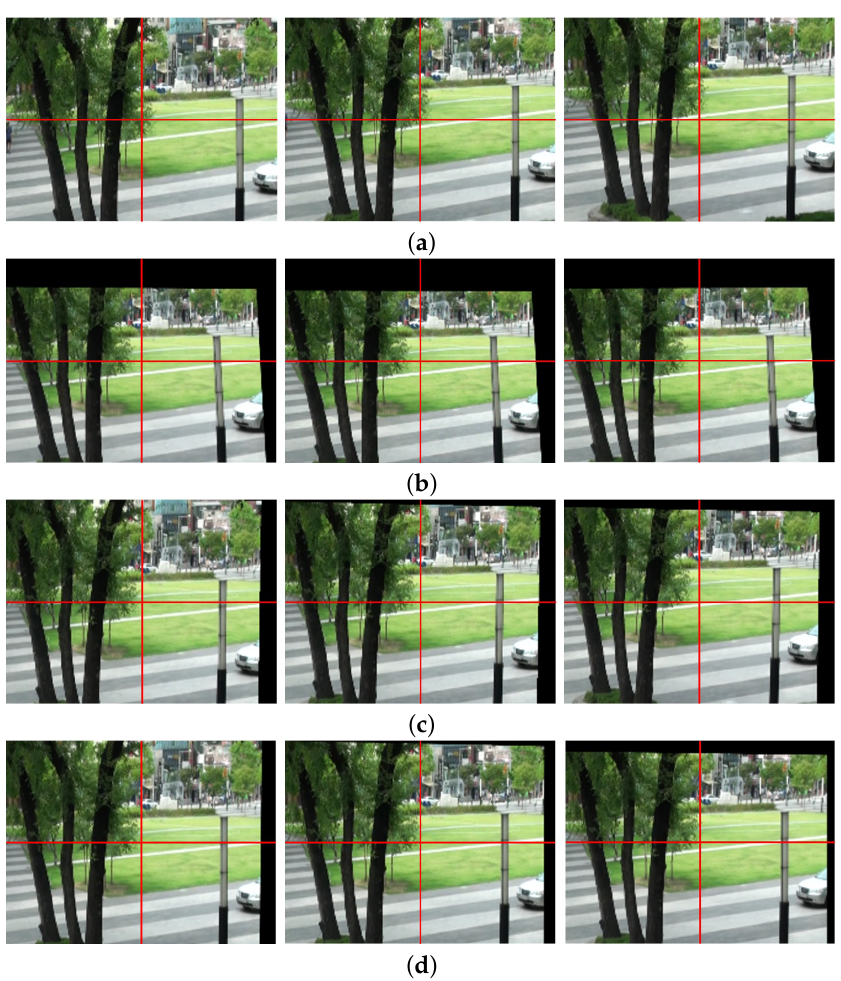
Figure 7. Experimental results of various video stabilization methods: ( a ) the expanded shaky video frames (80th, 81st, and 82nd frames), ( b ) the stabilized video using the global camera path using feature detection [7], ( c ) the bundled path algorithm [14], and ( d ) the proposed method.